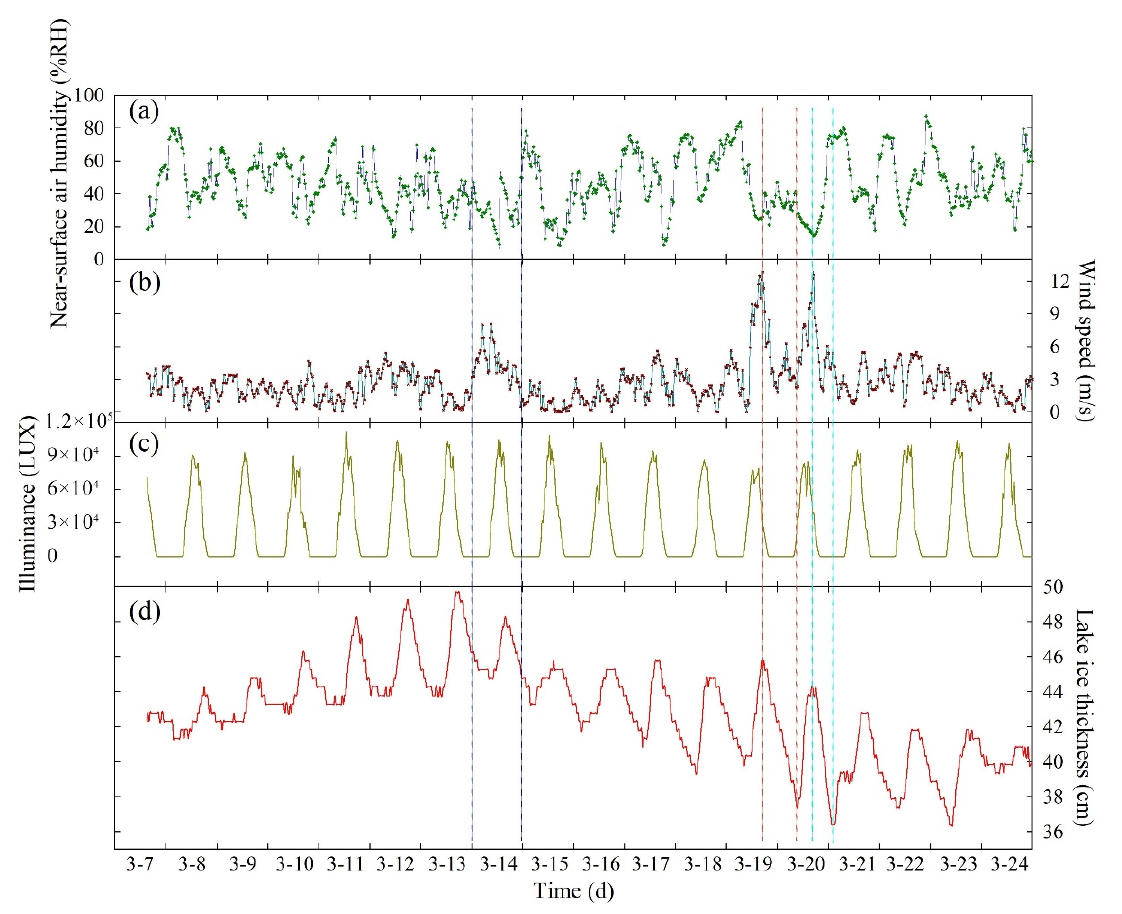
Figure 10. Changes in near-surface air humidity ( a ), wind speed ( b ), illuminance ( c ), and lake ice thickness ( d ) near the GPR ice monitoring system from 7–24 March 2021.